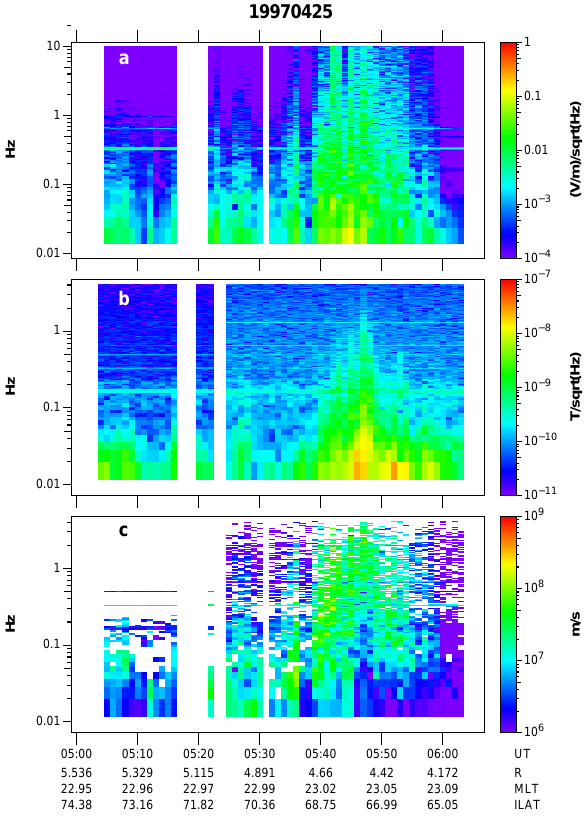
Fig. 10. E , B , and E/B ratio from Polar EFI and MFE instruments. EFI spin plane electric field spectrogram (a) , MFE spectrogram (b) , ratio of panels (a) and (b) (c) . Estimated MHD Alfv´en speed is ∼ 2 × 10 7